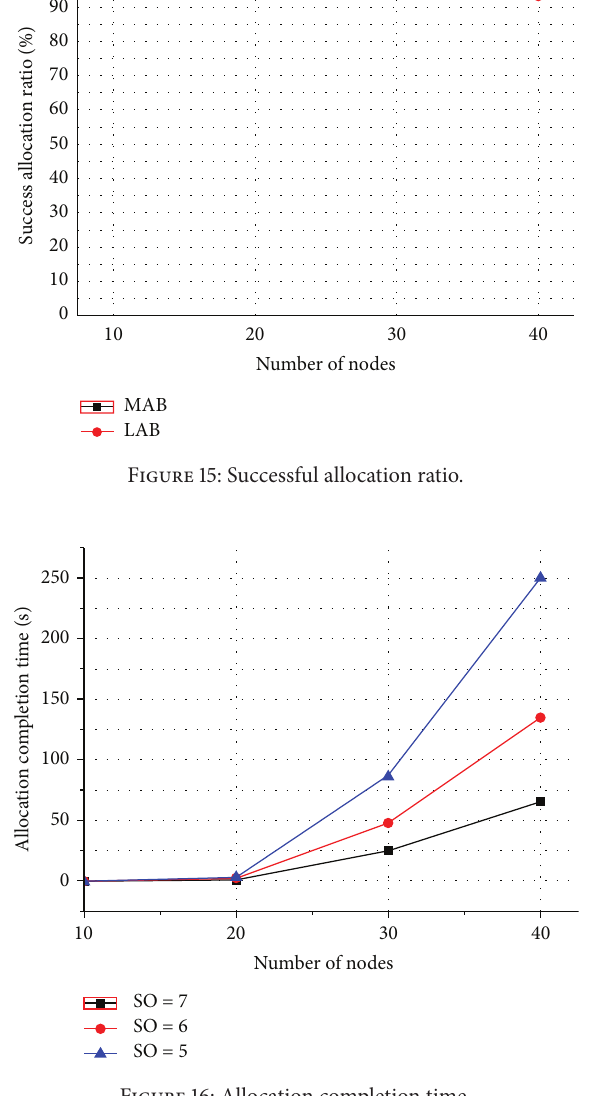
Figure 16: Allocation completion